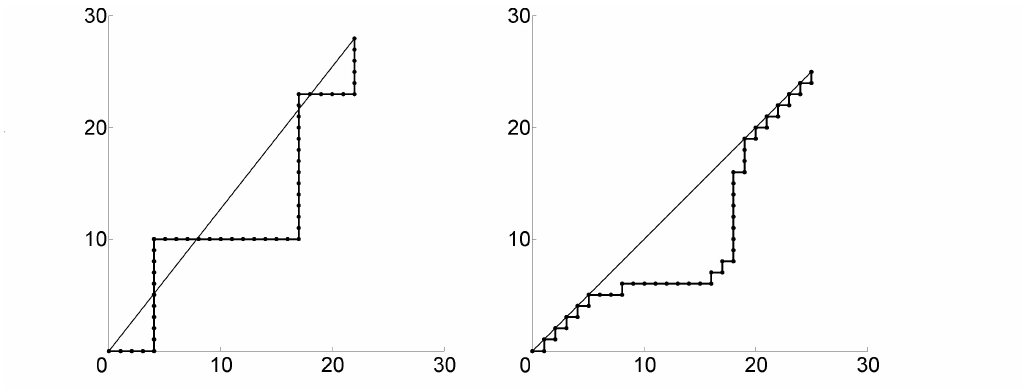
Figure 1: Left: the string s = x 4 y 10 x 13 y 13 x 5 y 5 and its corresponding monotone discrete path. Right: another string which has nearly the same adv and mdv as s , but a different nlm